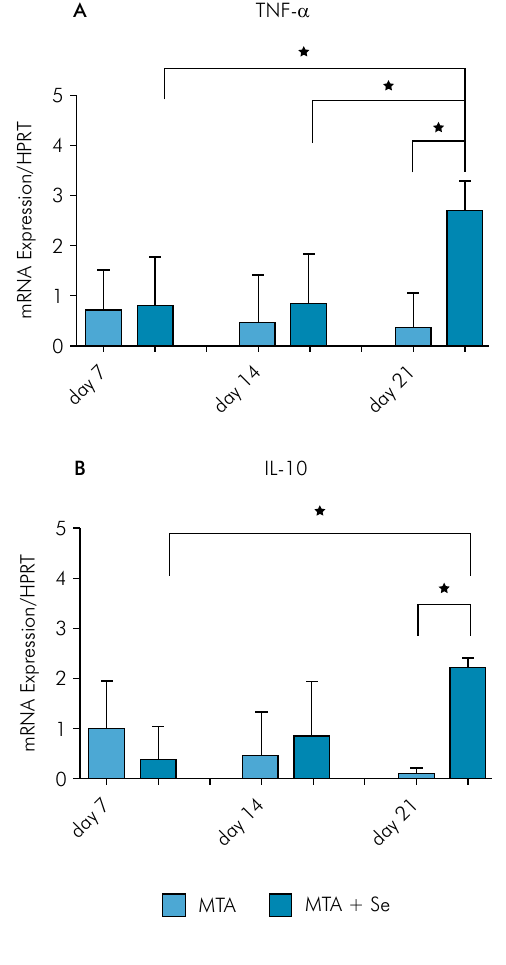
Figure 2. mRNA expression of TNF- α and IL-10 in the furcal area of germ free mouse subjected to experimental furcal perforation sealed with MTA or MTA+Se at 21 days. The expression levels were determined by real time PCR and quantified by comparison with a housekeeping gene (HPRT). Bars represent the average of five experiments performed in duplicate, while horizontal lines represent the standard